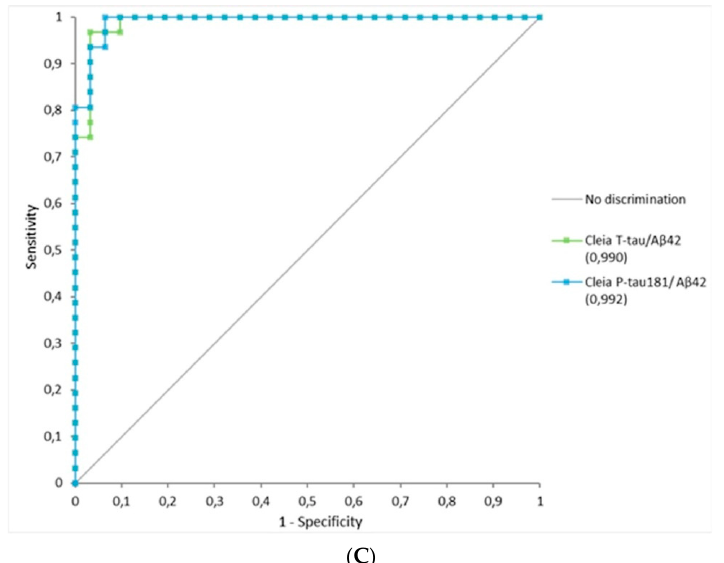
Figure 2. Receiver operating characteristic (ROC) curves to distinguish between AD patients and controls: ( A ) AUC analysis for ELISA A β 42, T-tau and P-tau181 ( B ) AUC analysis for CLEIA A β 42, A β 42/A β 40, T-tau and P-tau181, ( C ) AUC analysis for ratio T-tau/A β 42 and P-tau181/A β Table 2. CSF optimal thresholds and related 95% confidence intervals for ELISA and CLEIA.